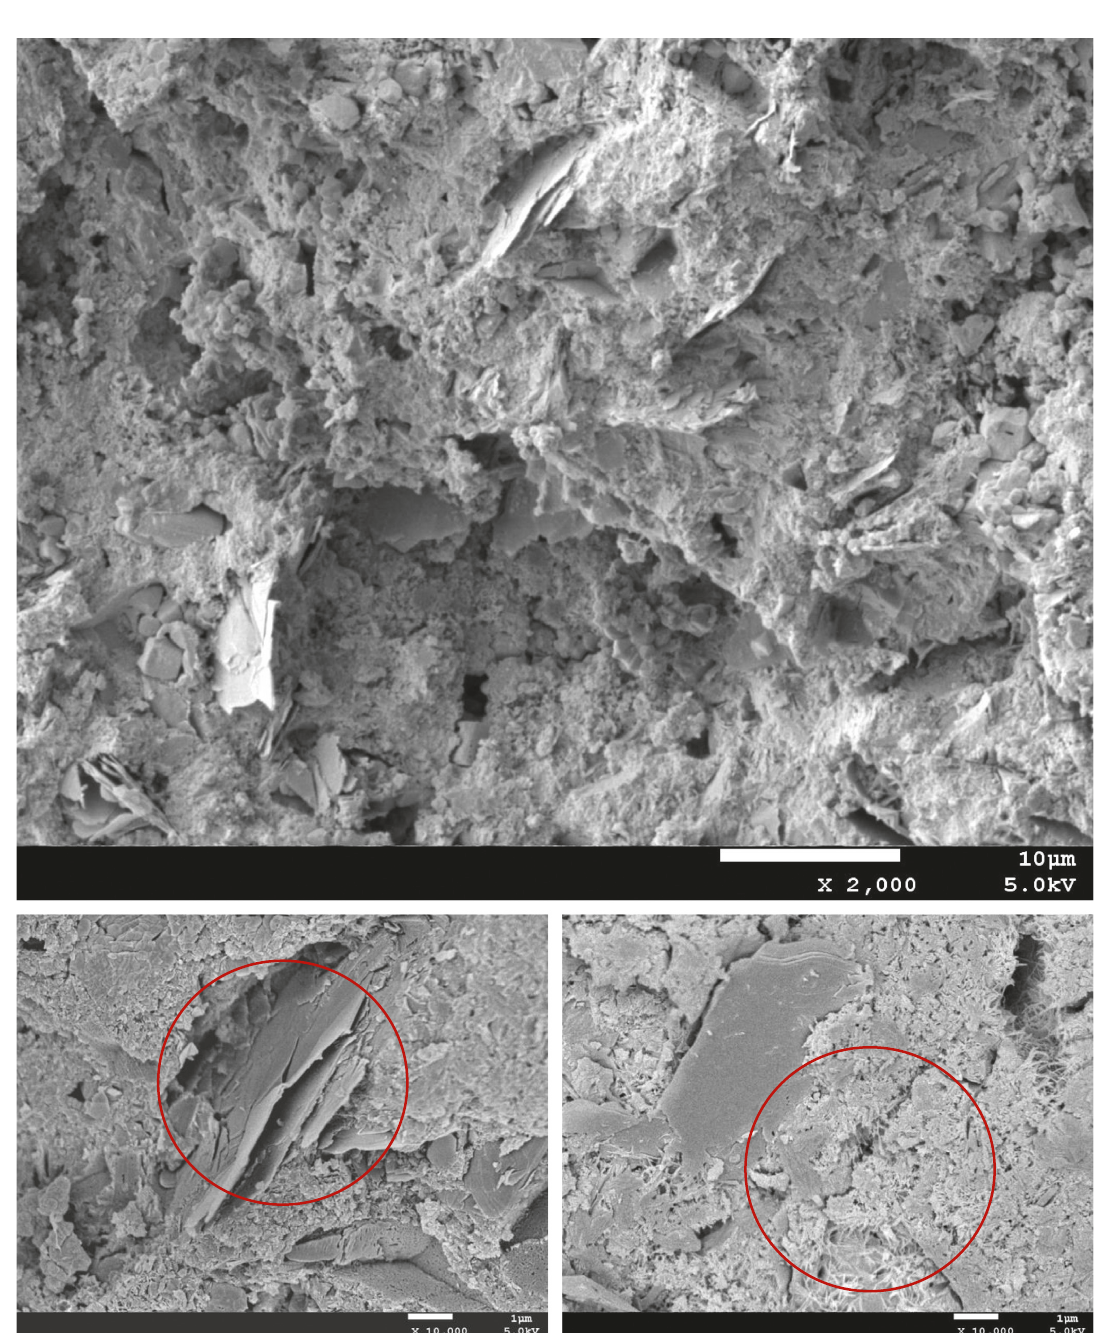
Figure 9: Mechanical contribution of ZRJ-S1 additive to cement-based